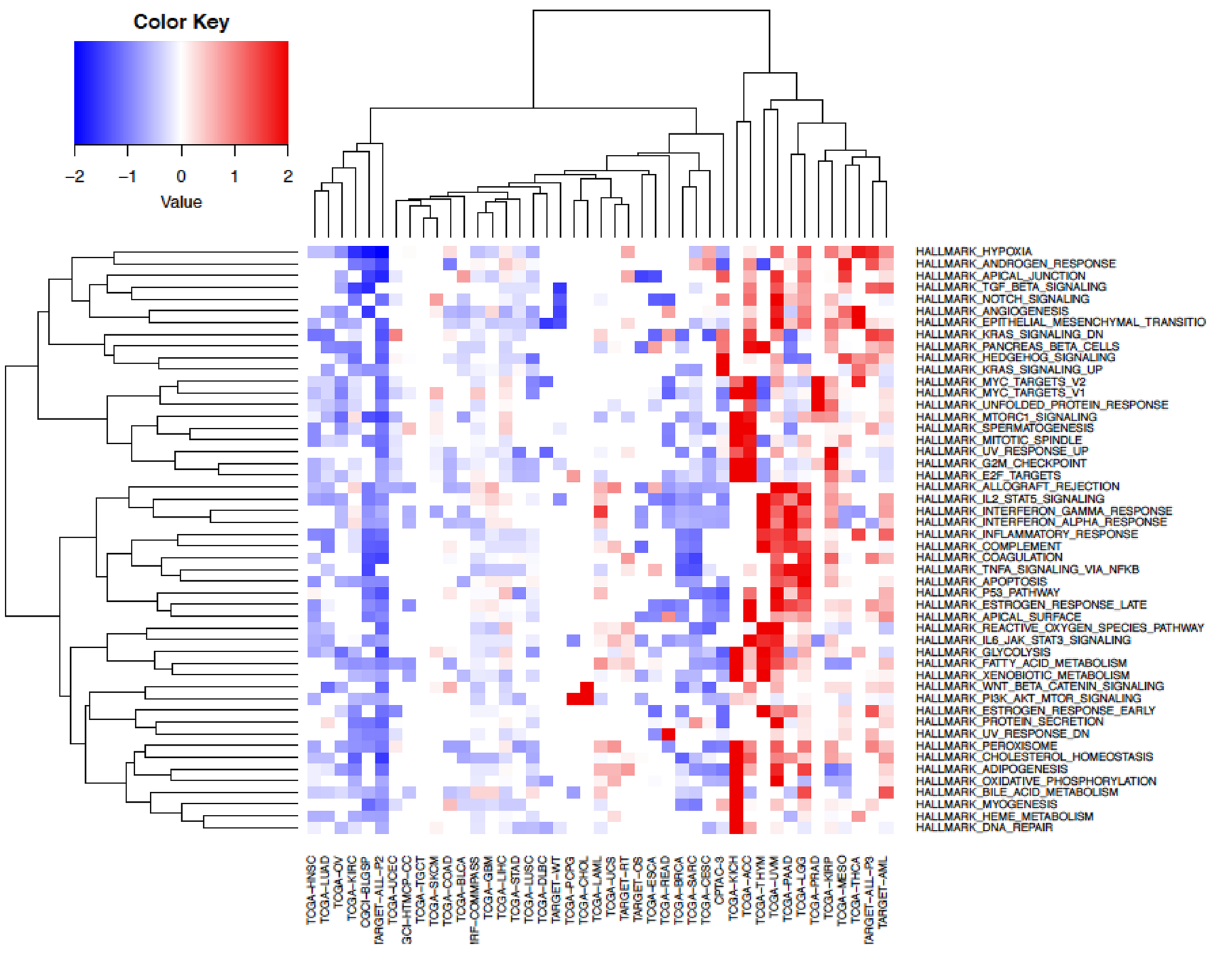
Figure 4. Gene sets-based survival analysis. Hierarchical clustering of Broad hallmark-associated gene sets and cancer types. The predicted survival outcomes are visualized using Euclidean distance and complete linkage method, using hazard ratios values for each hallmark associated gene set (n = 50) across all cancer datasets (n =